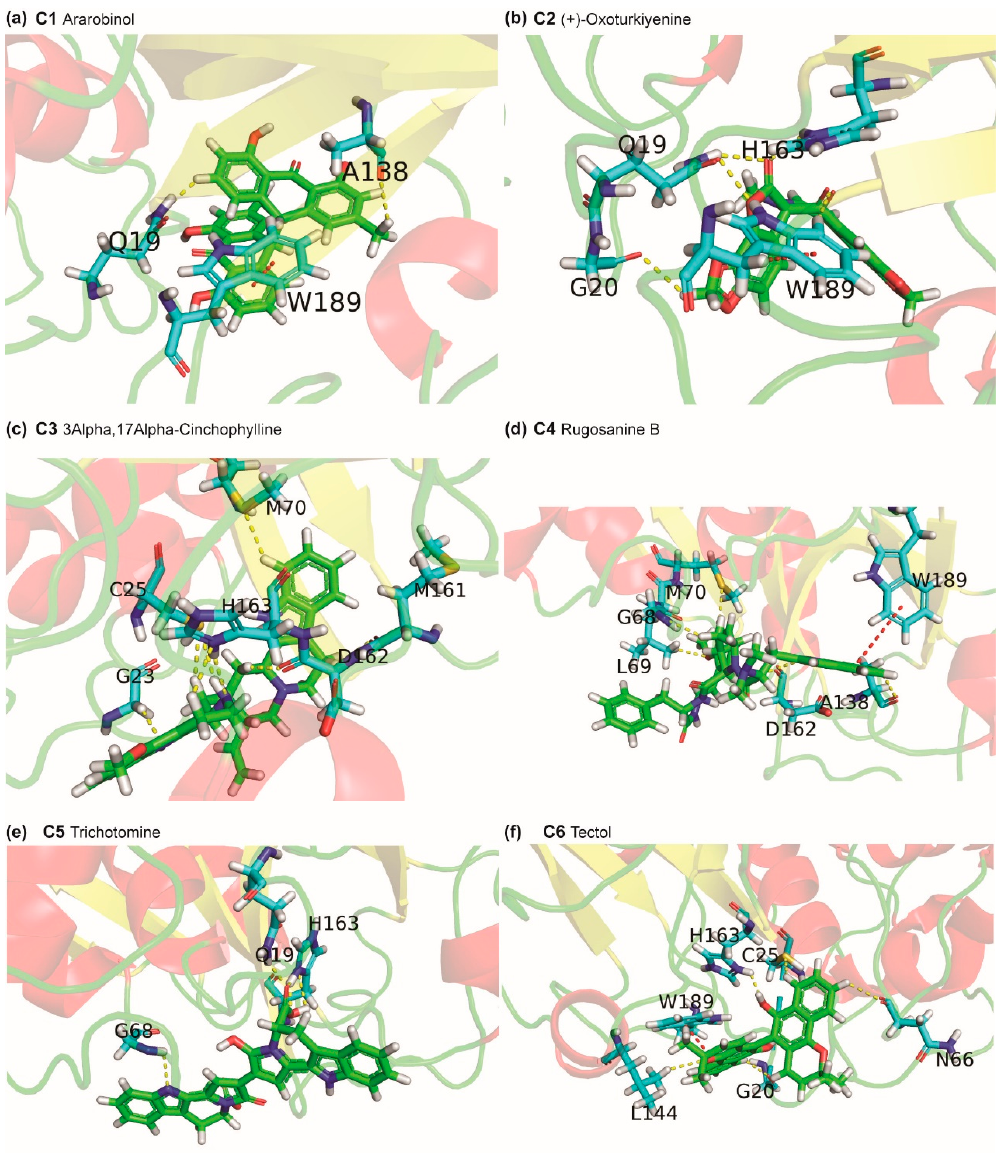
Figure 7. Cartoon representation of the protein-ligand interactions of the phytochemical inhibitors of cathepsin L. Interactions of cathepsin L residues with atoms of ( a ) C1, ( b ) C2, ( c ) C3, ( d ) C4, ( e ) C5, and ( f ) C6. The carbon atoms of the ligand are shown in green colour while the carbon atoms of the amino acid residues in cathepsin L are shown in cyan colour. Cathepsin L residues interacting with the ligand atoms via hydrogen bonds or π - π stacking are labelled with the corresponding single letter residue code along with their position in the protein sequence. The hydrogen bonds and π - π stacking are displayed using yellow and red dotted lines, respectively.